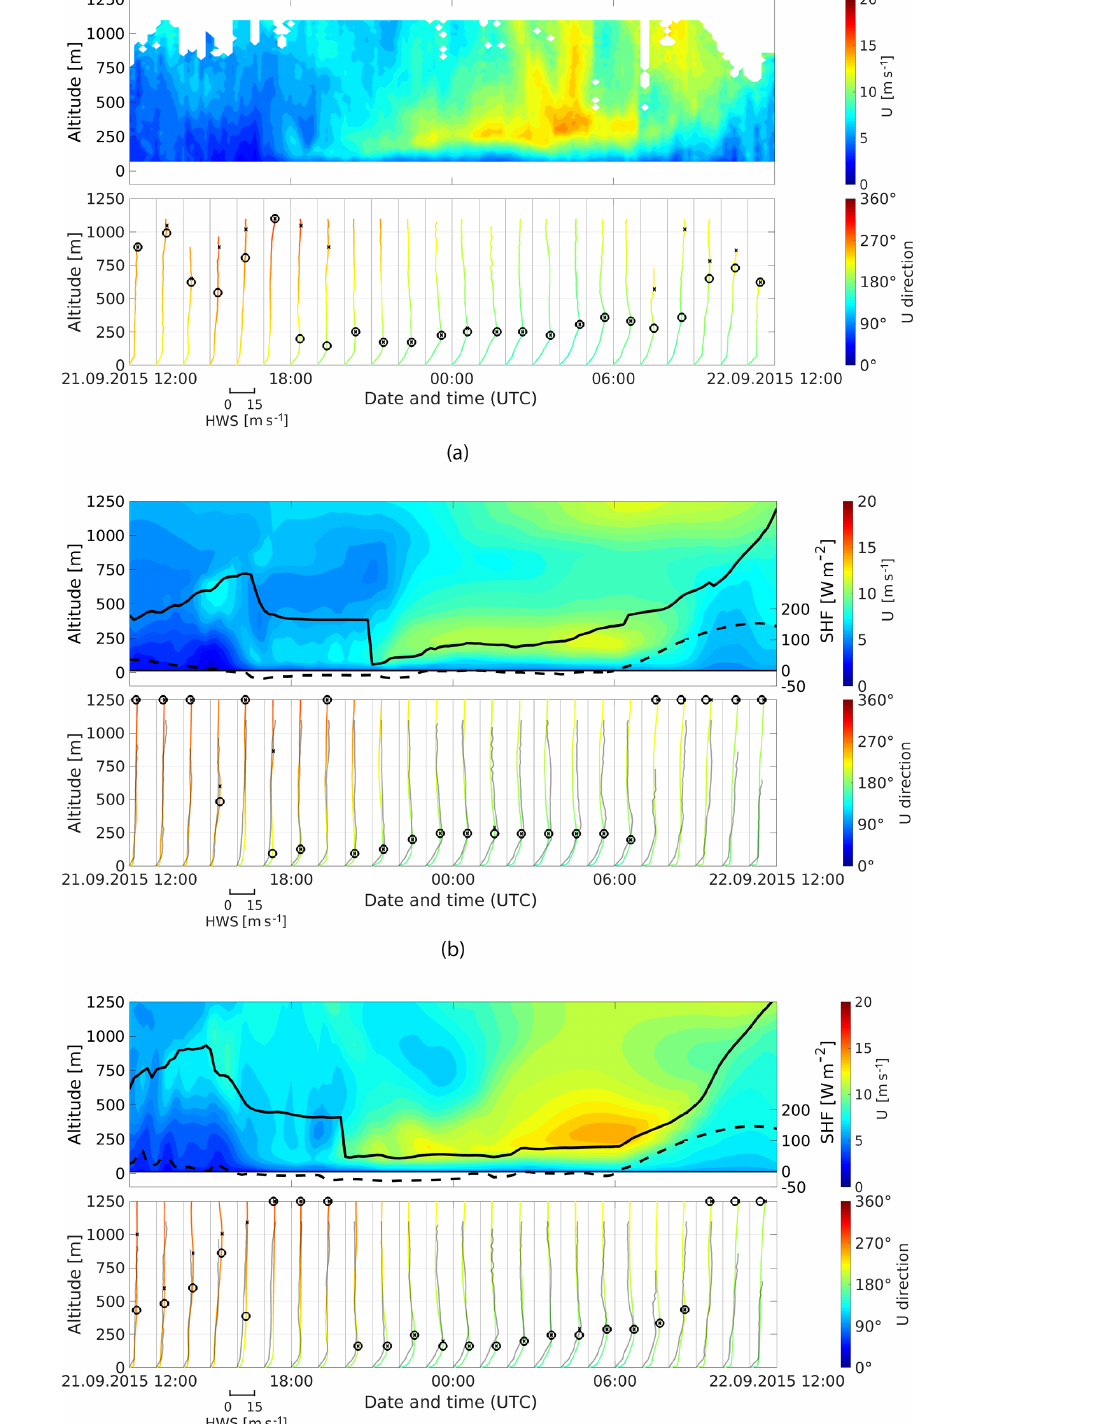
Figure 4. Visualization of modeled and measured 10min mean wind speed and wind direction for 21 September 2015. (a) The measured lidar data set, (b) the observation-nudged OBS data set and (c) results from the unnudged reference NoOBS model. (a) The wind speed and WRF-calculated SHF (dashed line). (c) The hourly 10min mean wind speed profile colored according to wind direction. X marks the altitude of highest wind speed and (cid:13) the optimal AWES operating altitude calculated as described in Sect.